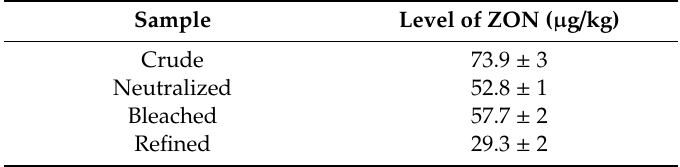
Table 4. E ff ect of the refining stages on zearalenone content (mg / kg oil) of maize